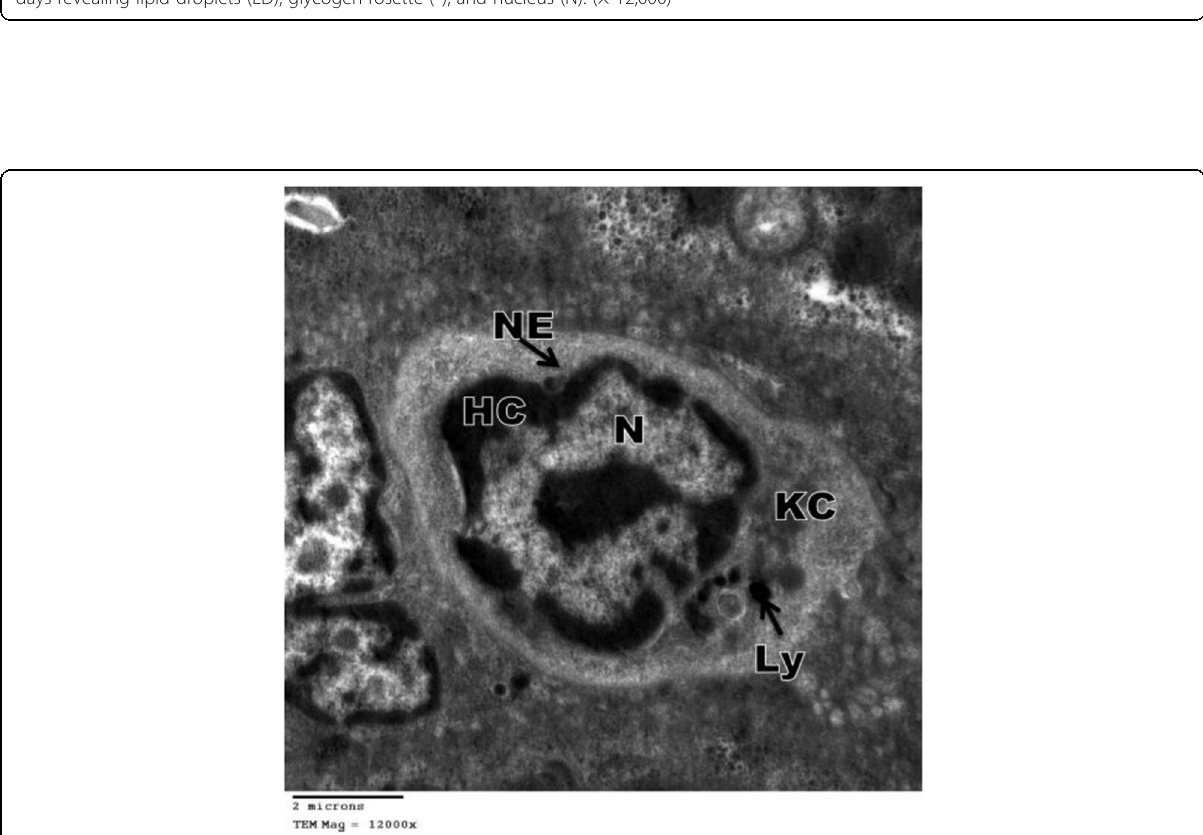
Fig. 31 An electron micrograph of a Kupffer cell of treated mouse with Tamiflu (16 mg/kg b.wt.) in addition to Adamine (20 mg/kg b.wt.) for 15 days revealing lysosomes (Ly) and nucleus (N) with irregular nuclear envelope (NE) with heterochromatin attached to the inner membrane (HC) of the nuclear envelope. (× 12,000)